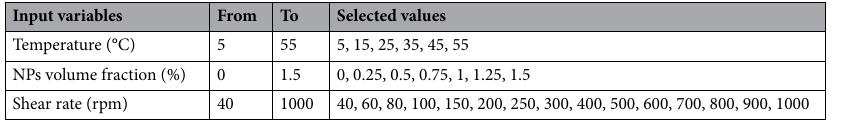
Table 2. The studied range for input